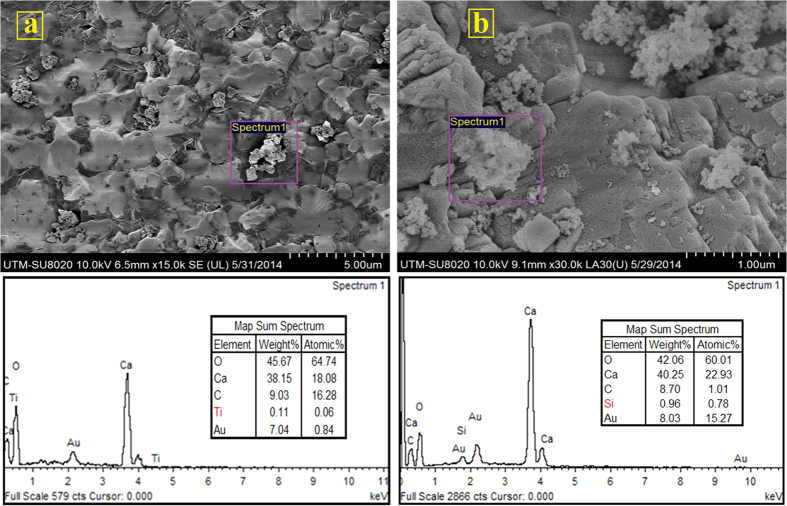
(a) FESEM-EDX analyses from limestone grains after the transport experiments, (a) TiO2-NPs, (b) SiO2-NPs. (Right image was taken from a grain located in the top of column and left image was taken from a grain located in the entrance of column).